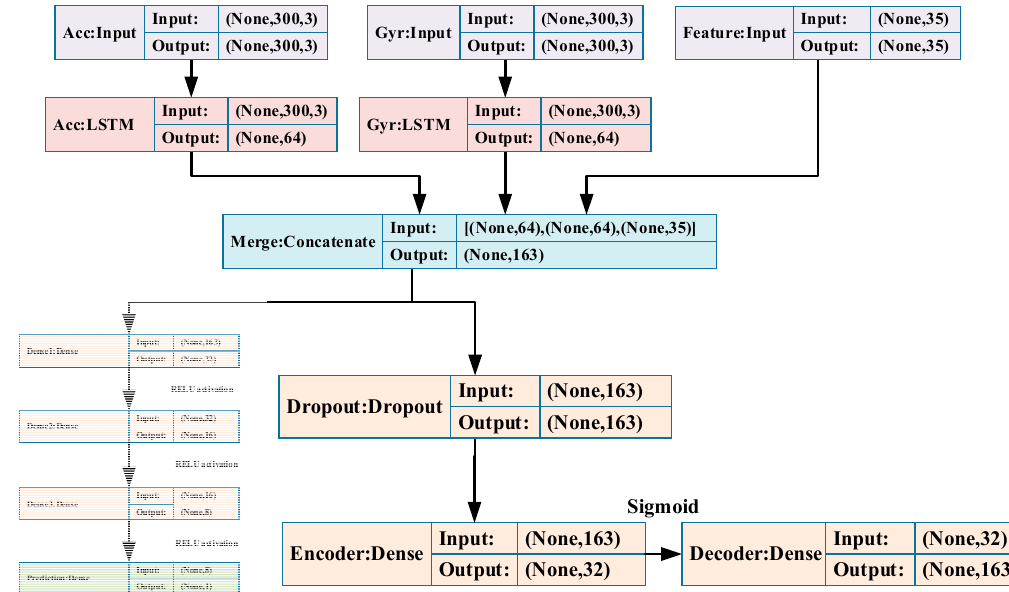
Figure 8. The architecture and parameters of DAE model.